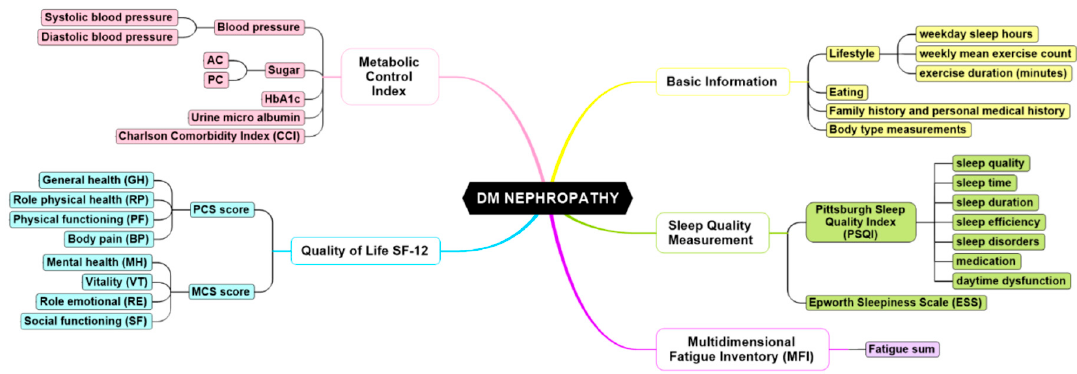
Figure 1. The data collection process and the features obtained from the questionnaires.